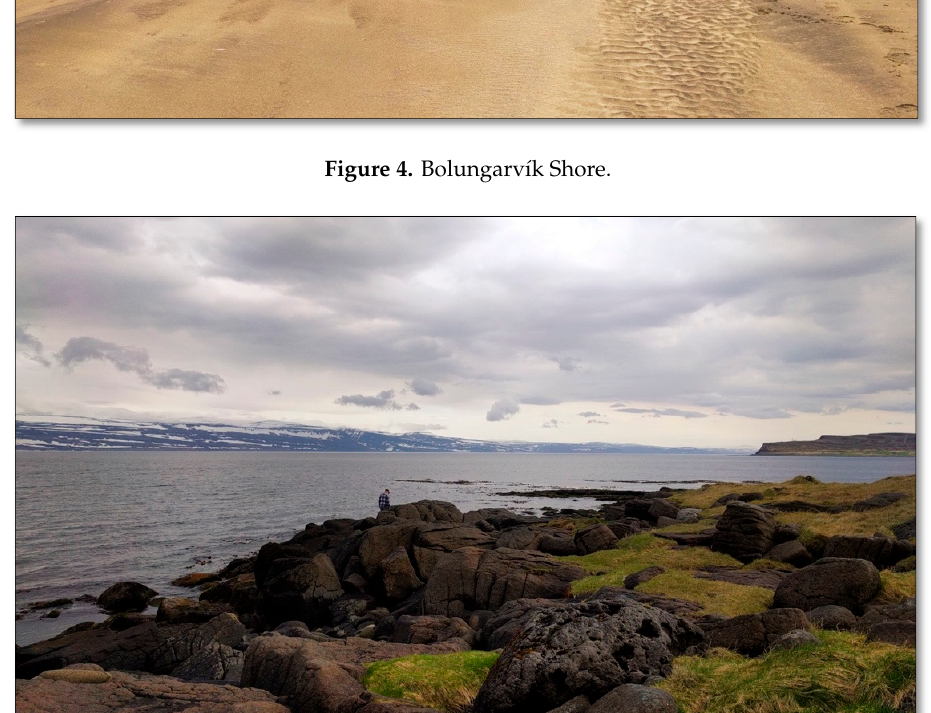
Figure 5. Skeljav í k Figure 5. Skeljavík Shore.